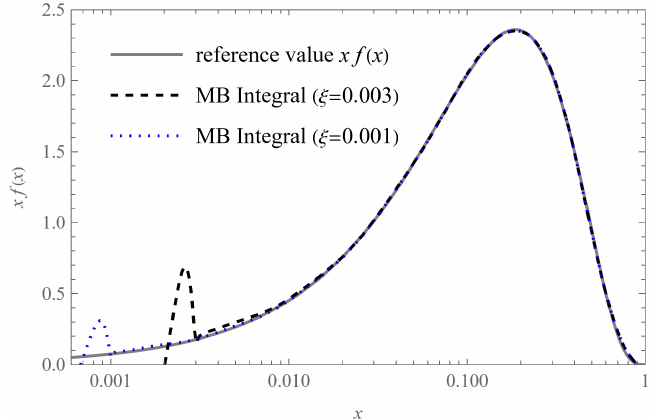
Figure 4 . A plot showing that the Mellin-Barnes (MB) integral can indeed reproduce the reference PDF f ( x ) = 18 . 6 x − 0 . 2 (1 − x ) 3 . 5 when x (cid:29) ξ , where ξ serves as the regulator. On the other hand, in the x . ξ region, the PDFs calculated this way are strong affected by the none-zero skewness ξ and deviate from the reference